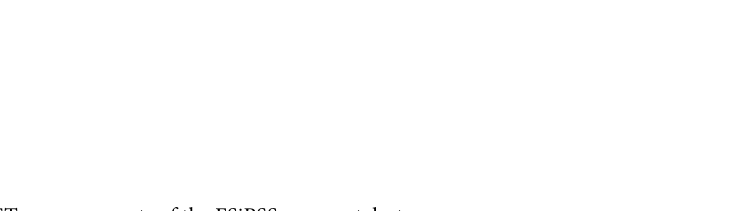
Table 2. Results from the BET measurements of the FSiPSS nano-catalyst.